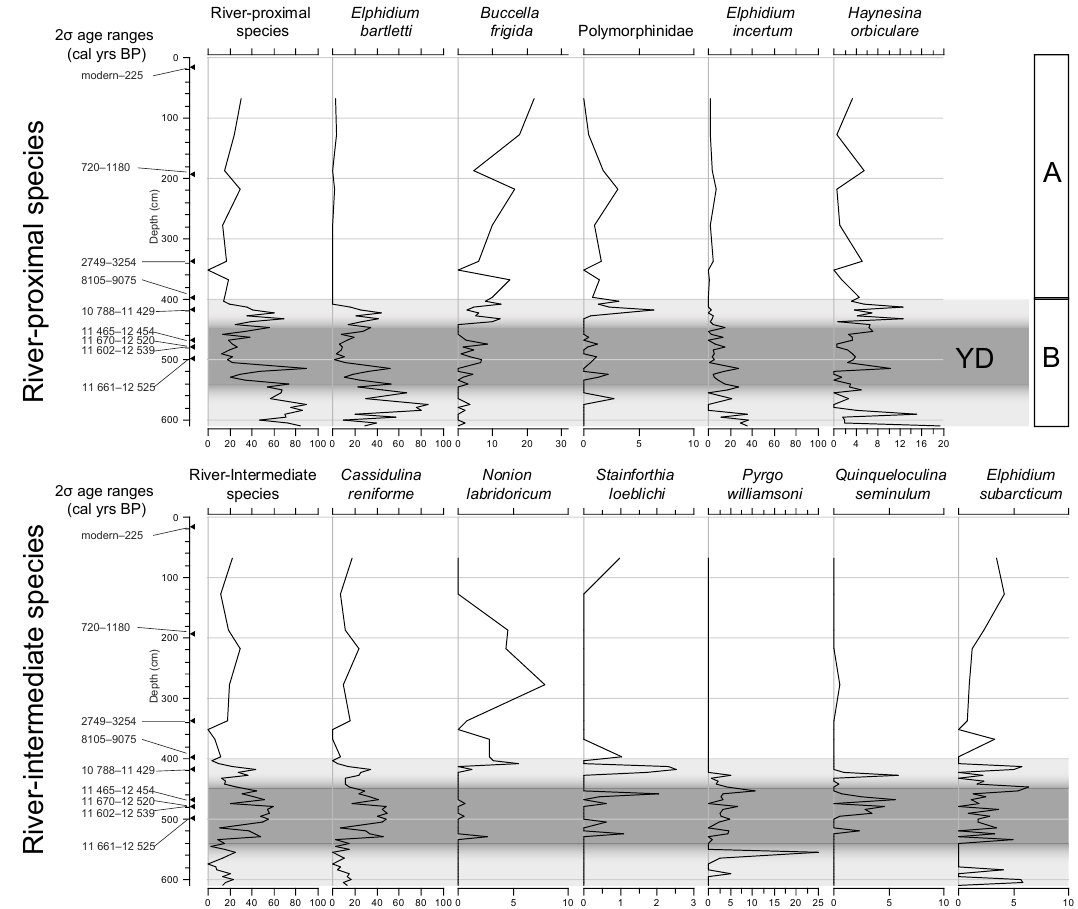
Figure 5. The distribution of benthic foraminifers in the SWERUS-L2-4-PC1 core showing species percent abundance and depth of the sam- ples in the core. The upper panel shows river-proximal species, and the lower panel shows river-intermediate species. Ecological classification for species groups is from Polyak et al. (2002). In the river-proximal species group, Elphidium bartletti is common. In the river-intermediate species group, Cassidulina reniforme is dominant. Shading estimates the boundary between the late deglacial (Younger Dryas, Preboreal) and the Holocene intervals. See also Fig. 7. Stratigraphic units A and B are based on multiple criteria and discussed in the text and in Jakobsson et al.